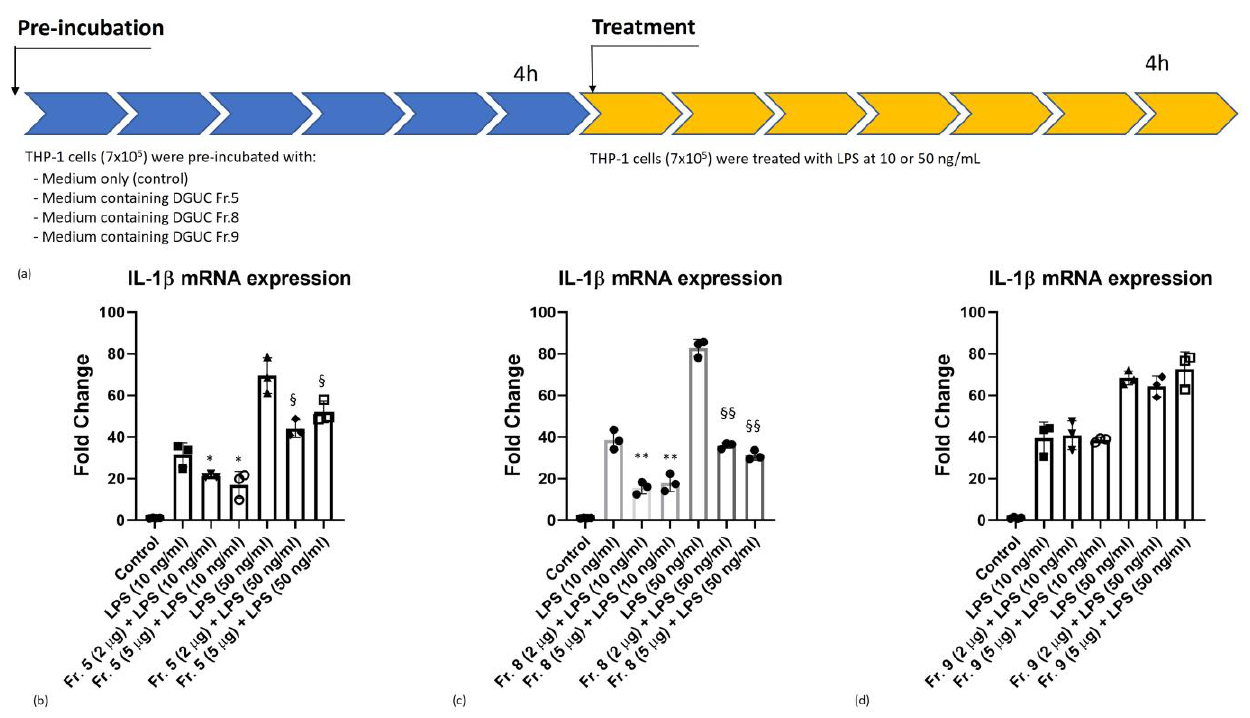
Fraction 9, respectively, measured by NTA.